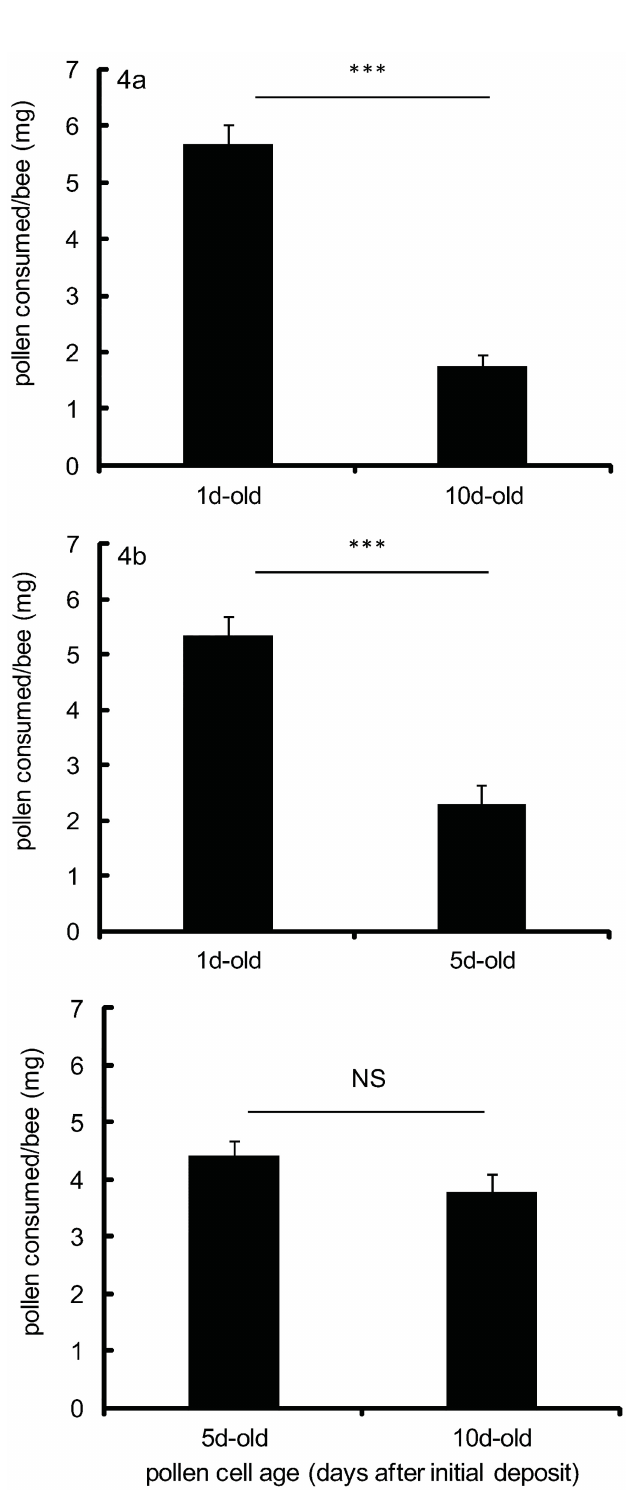
Fig 4. Young adult worker consumption of different-aged pollens ((a) 1d-old vs. 10d-old, b) 1d-old vs. 5d-old, c) 5d-old vs. 10d-old) presented in a dual choice assay. * The amount of each stored pollentype consumed by cage workers variedsignificantly ( *** p < 0.0001)or did not vary significantly (NS) by a pairedt- test (p < 0.05).Error bars are S.E.